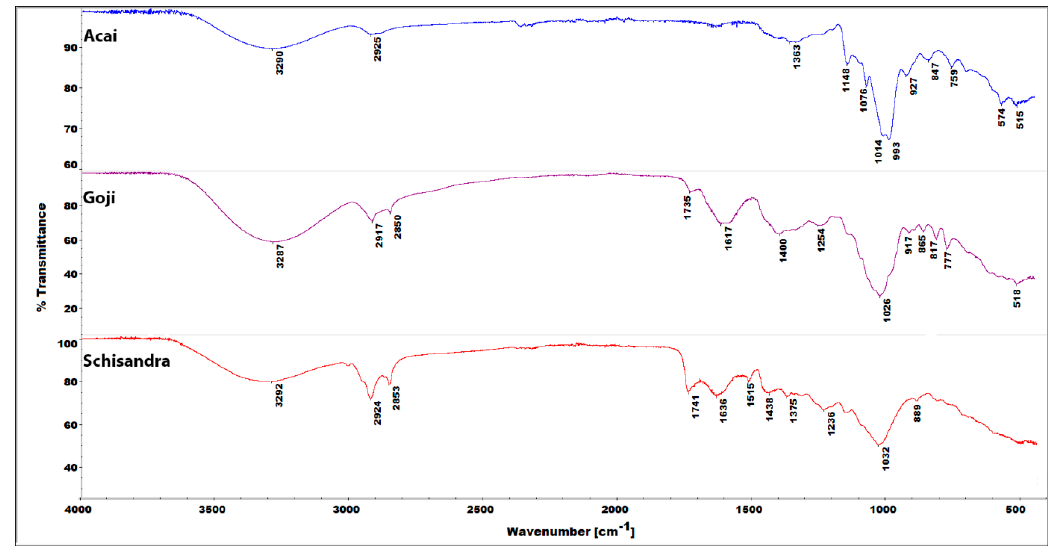
Figure 6. FT-IR (ATR) spectra of plant powder samples: açaí (top), goji (middle), schisandra (bottom).